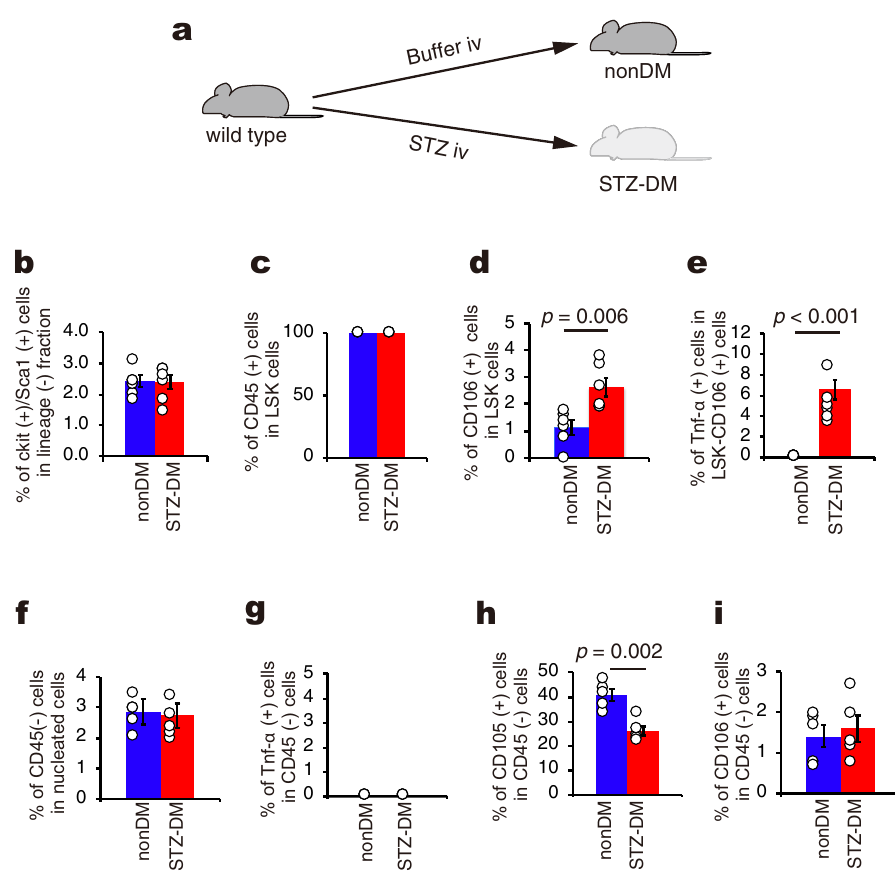
Fig. 3 Localization of CD45-, CD106-, and TNF- α -positive cells in the bone marrow stem cell fraction. a A schematic experimental design for the generation of diabetic mice (STZ-DM) and nonDM mice. b FACS analysis of LSK cell in nonDM and STZ-DM. Percentage of LSK cells in the mononuclear cell fraction from total bone marrow in nonDM and STZ-DM. ( n = 6 per group). c FACS analysis of CD45-positive cell in LSK cells from nonDM and STZ- DM. Percentage of CD45-positive cells in the LSK cell fraction from mononuclear cells in nonDM and STZ-DM ( n = 3 per group). d FACS analysis of CD106- positive cell in LSK cells from nonDM and STZ-DM. Percentage of CD106-positive cells in the LSK cell fraction from mononuclear cells in nonDM and STZ- DM ( n = 6 per group). e FACS analysis of TNF- α -positive cells in LSK-CD106 cells from nonDM and STZ-DM. Percentage of TNF- α -positive cells in the LSK- CD106 cell fraction from mononuclear cells in nonDM and STZ-DM ( n = 6 per group). f FACS analysis of CD45-negative cell in nucleated cells in nonDM and STZ-DM total bone marrow. Percentage of CD45-negative cells in the nucleated cell fraction in nonDM and STZ-DM total bone marrow ( n = 5 per group). g FACS analysis of TNF- α -positive cells in CD45-negative cells from nonDM and STZ-DM. Percentage of TNF- α -positive cells in the CD45-negative cell fraction from total bone marrow in nonDM and STZ-DM ( n = 3 per group). No TNF- α -positive cells were detected any mice. h Percentage of CD105- positive cells in the CD45-negative cell fraction from total bone marrow in nonDM and STZ-DM ( n = 5 per group). i Percentage of CD106-positive cells